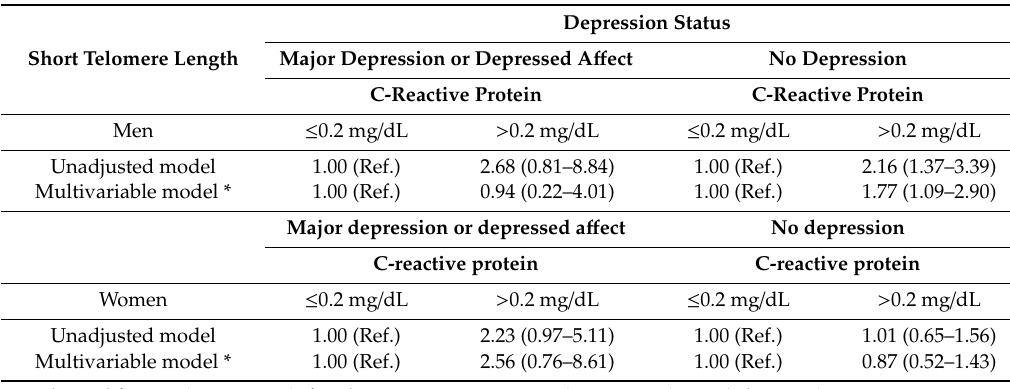
Table 4. The combined e ff ects of inflammation and depression status on shortened telomere length by